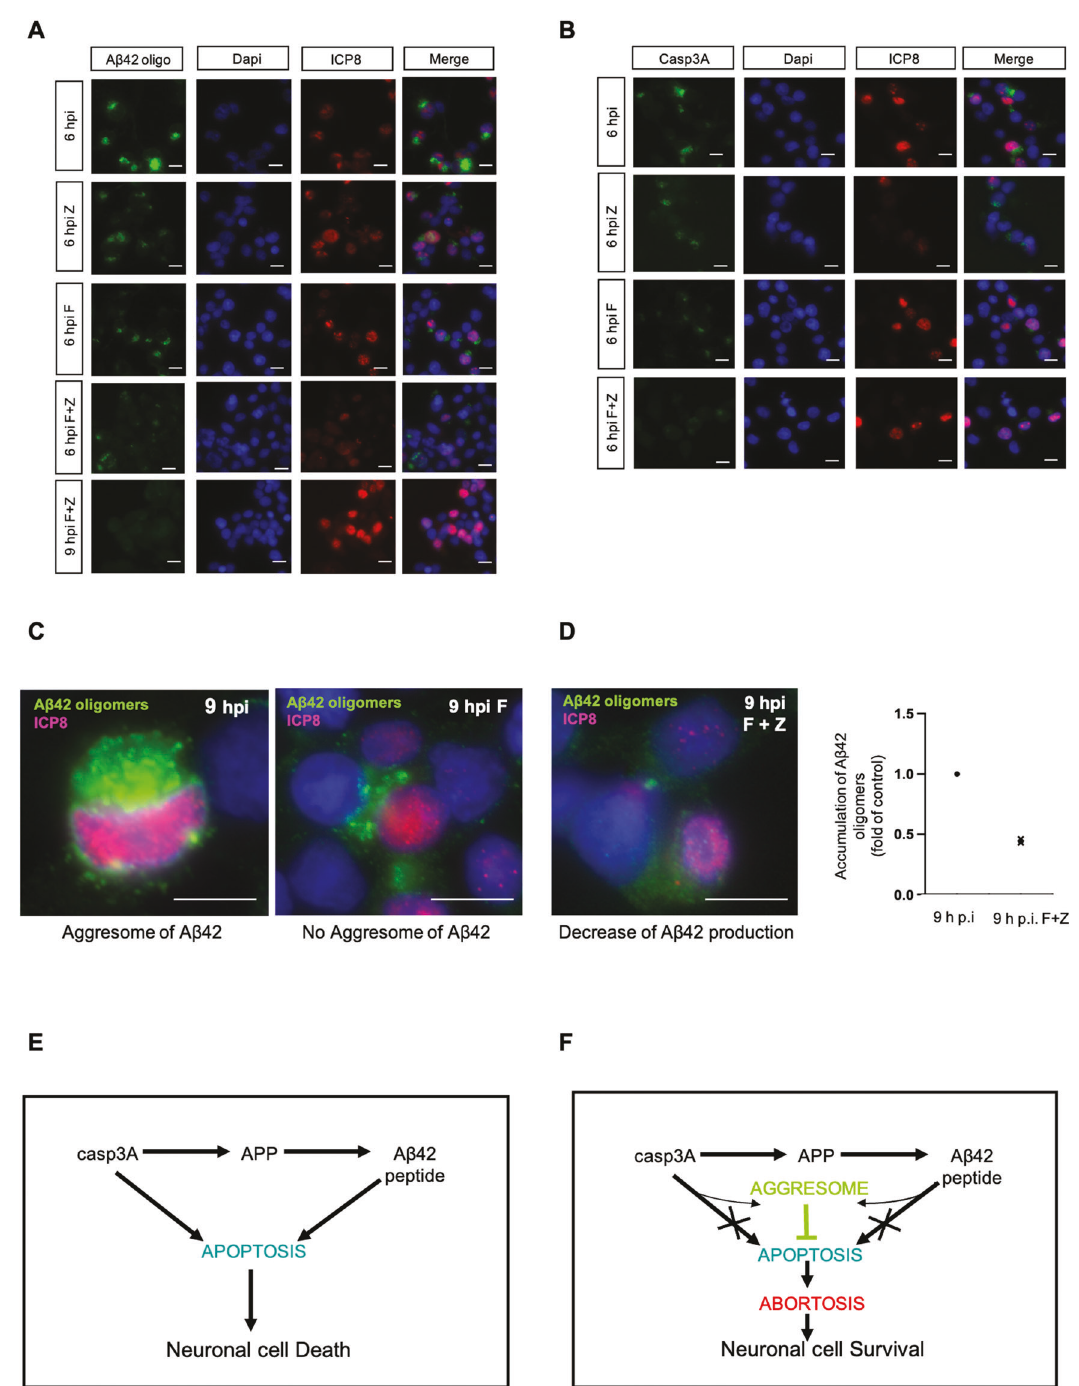
Fig. 5 Abortosis-like event by aggresome formation is a cellular mechanism. A Characterization of ruban type aggresome of A β 42 oligomers and spheric type aggresome of casp3A by confocal microscopy analysis and 3D reconstructions. A β 42 oligomers (A1976-Sigma, green signal), γ tubulin as a MTOC control (red signal), scale bar = 10 μ m. B FACS analysis of casp3A positive cells using anti-casp3 cleaved antibody (9664-Cell signaling) at NI, 3, 6 and 9 h p.i., **** p -value < 0.0001 n = 1. C FACS analysis of fragmented DNA positive cells at NI, 3, 6 and 9 h p.i, **** p -value < 0.0001 n = 2. Experimental conditions for D and E : HSV-1 infection with or without ALLN treatment. D FACS analysis of fragmented DNA positive cells at NI and 9 h p.i **** p -value < 0.0001 n = 1. E IF analysis of casp3A (9664-Cell signaling) at 9 h p.i. Viral protein ICP8 as control of infection (magni fi cation X40), scale bar = 10 μ m. F IF analysis of casp3A (9664-Cell signaling). Vimentine as control of aggresome formation (magni fi cation X100), scale bar = 10 μ m. Experimental conditions for G , H and I staurosporine treatment with or without ALLN pre-treatment. G FACS analysis of fragmented DNA positive cells at NT and 24 h, **** p -value < 0.0001 n = 3. H IF analysis of casp3A (9664- Cell signaling) at 24 h post-treatment. Vimentine as control of aggresome formation (magni fi cation X100), scale bar = 10 μ m . I May Grünwald Giemsa coloration of cells (magni fi cation X50) at 24 h post-treatment, scale bar = 50 μ m. Cells without apoptotic phenotype indicated by black